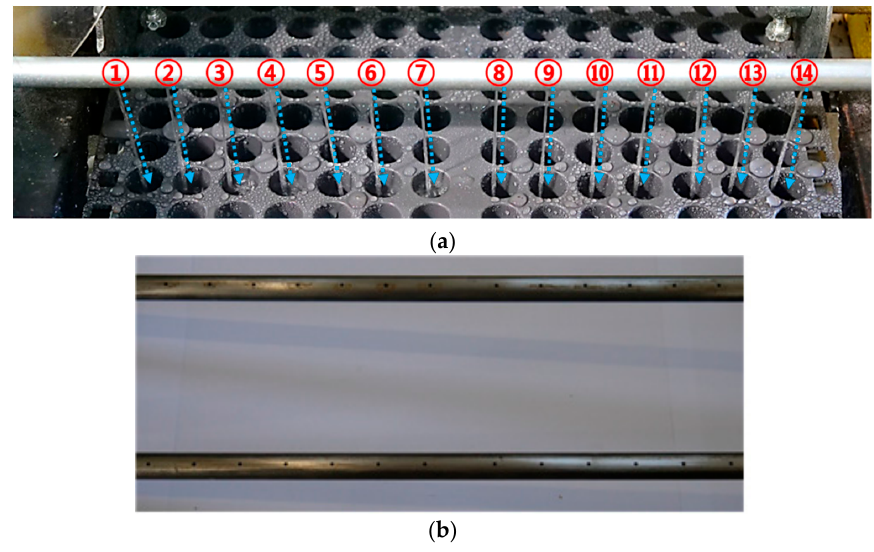
Figure 4. A view of the irrigation pipe: ( a ) position of the irrigation holes; ( b ) picture of the irrigation pipe.